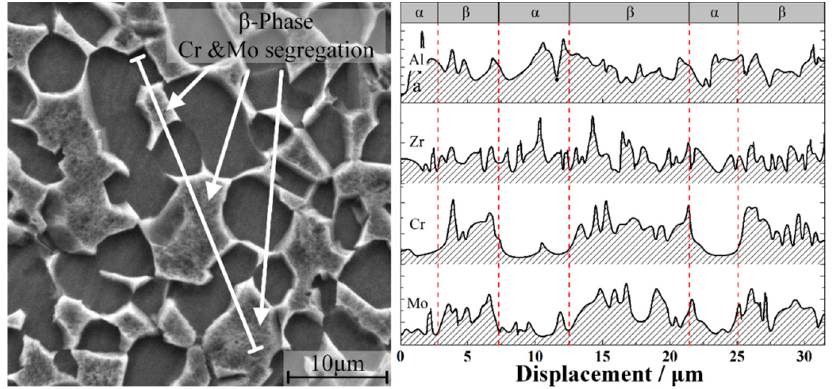
Figure 7. Segregation of Al, Mo, Cr and Zr in α + β phase.